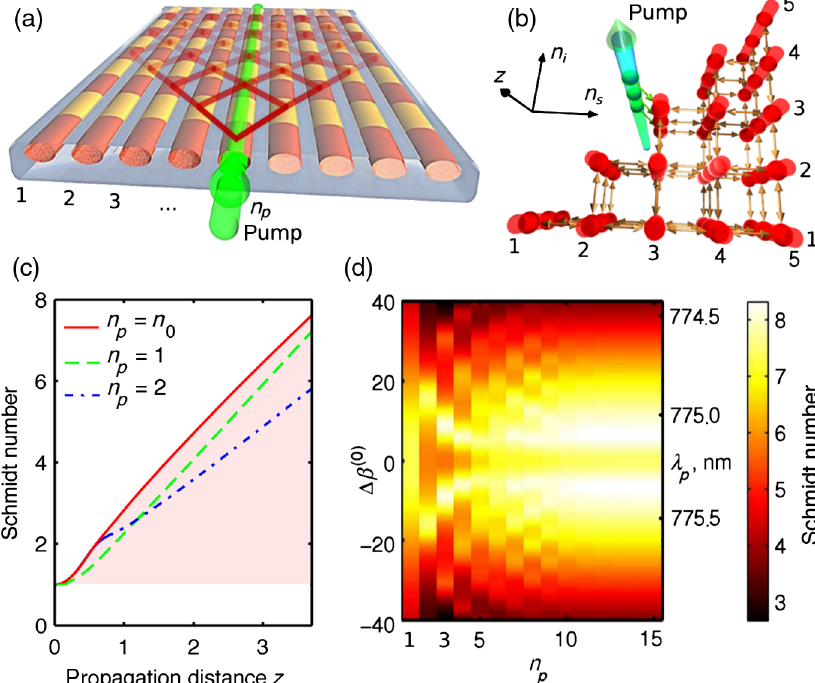
FIG. 1. (a) Schematic illustration of a quadratic nonlinear waveguide array. The pump (green) is coupled to the waveguide number n p . The photon pairs (red) are generated in the pump waveguide and propagate in the regime of quantum walks. (b) Representation of a photon-pair quantum walk on a lattice, where n s and n i are the signal and idler photon positions, respectively. A pump (green arrow) continuously generates photon pairs along the propagation direction z ; signal and idler photons walk between waveguides (orange arrows). (c) Photon-pair quantum-state Schmidt number versus the propagation distance z normalized to the coupling length π =C for zero phase mismatch Δ β ð 0 Þ ¼ 0 and different pump sites: n p ¼ n 0 (red), n p ¼ 1 (green), and n p ¼ 2 (blue). A larger Schmidt number corresponds to higher spatial biphoton entanglement. (d) Schmidt number at the output of the waveguide array versus the phase mismatch Δ β ð 0 Þ corresponding to the pump wavelength λ p and versus the pumped waveguide number n p near the edge of the waveguide